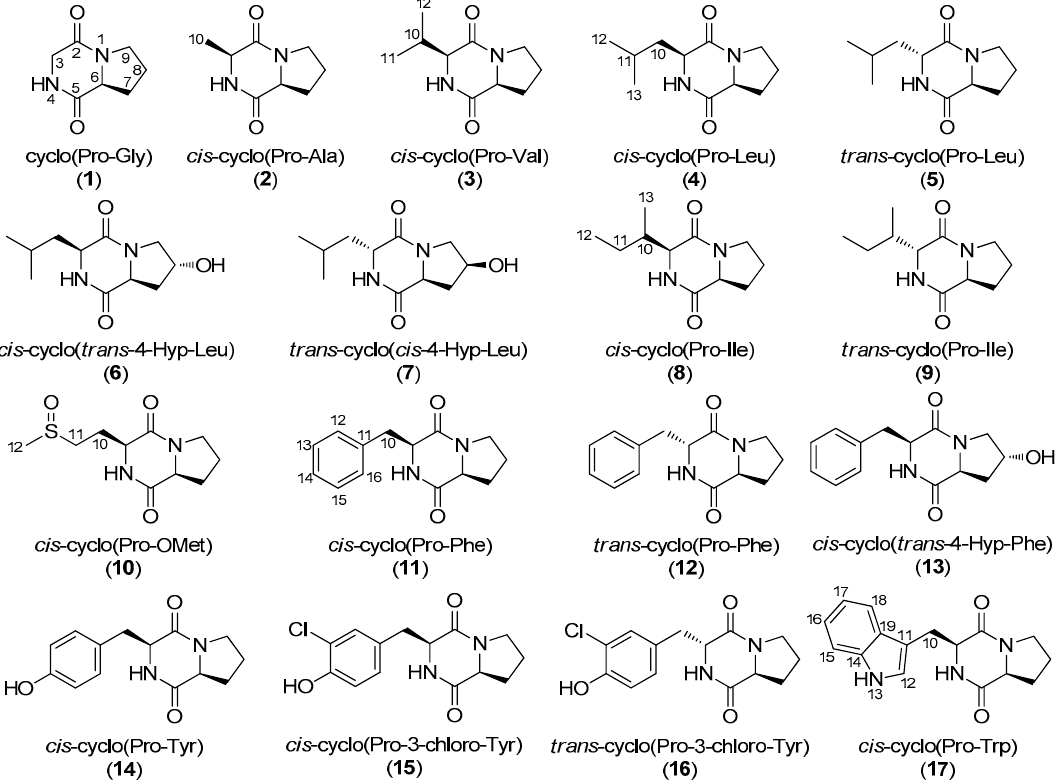
Figure1. Chemicalstructuresofcompounds 1 – 17 Figure 1. Chemical structures of compounds 1 – 17 isolated from various marine-derived bacterial strains.